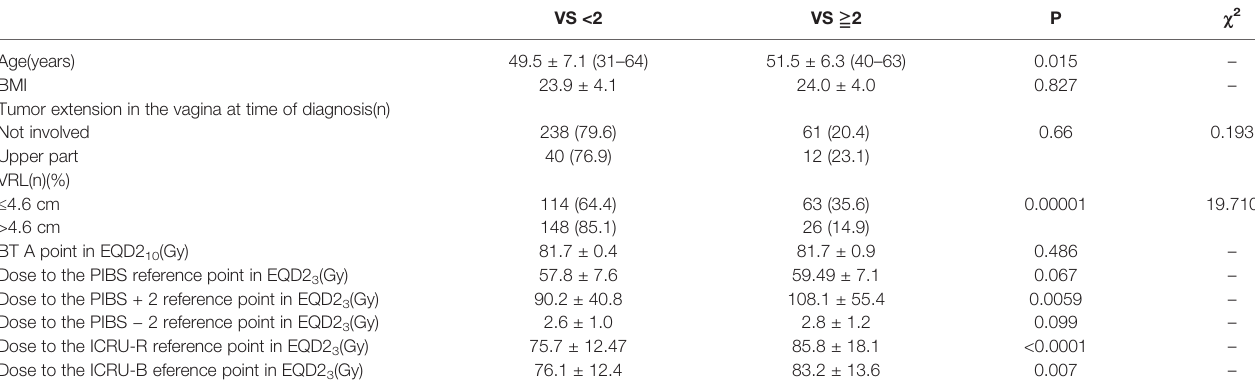
TABLE 2 | A comparison of risk factors for vaginal stenosis G ≥ 2 to <2.